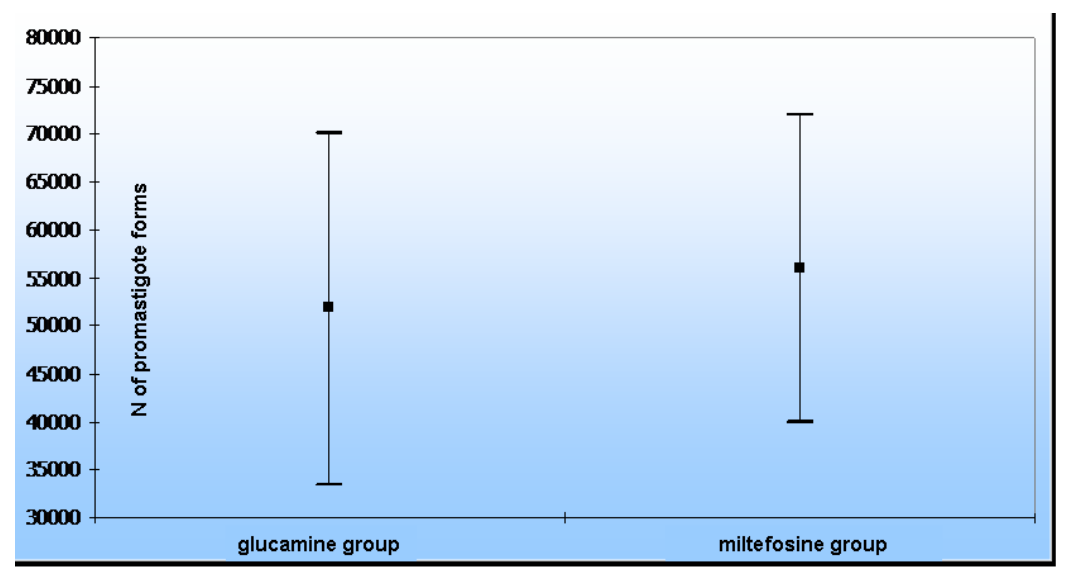
Figure 3. Average number of promastigote forms calculated using limiting dilution assay in mice treated with N-methyl glucamine only (Glucamine Group) and with N-